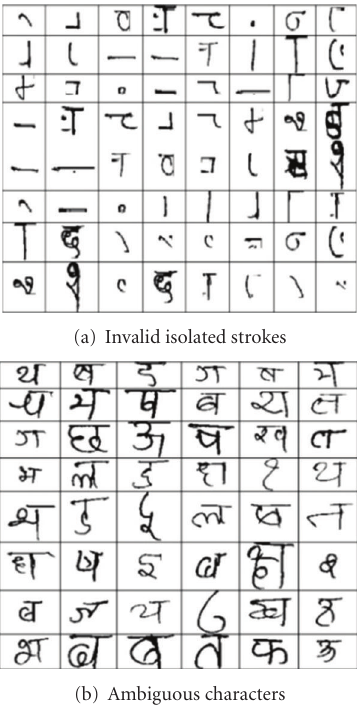
Figure 3: Invalid discarded data. Figure 4: Devnagari Numerals.